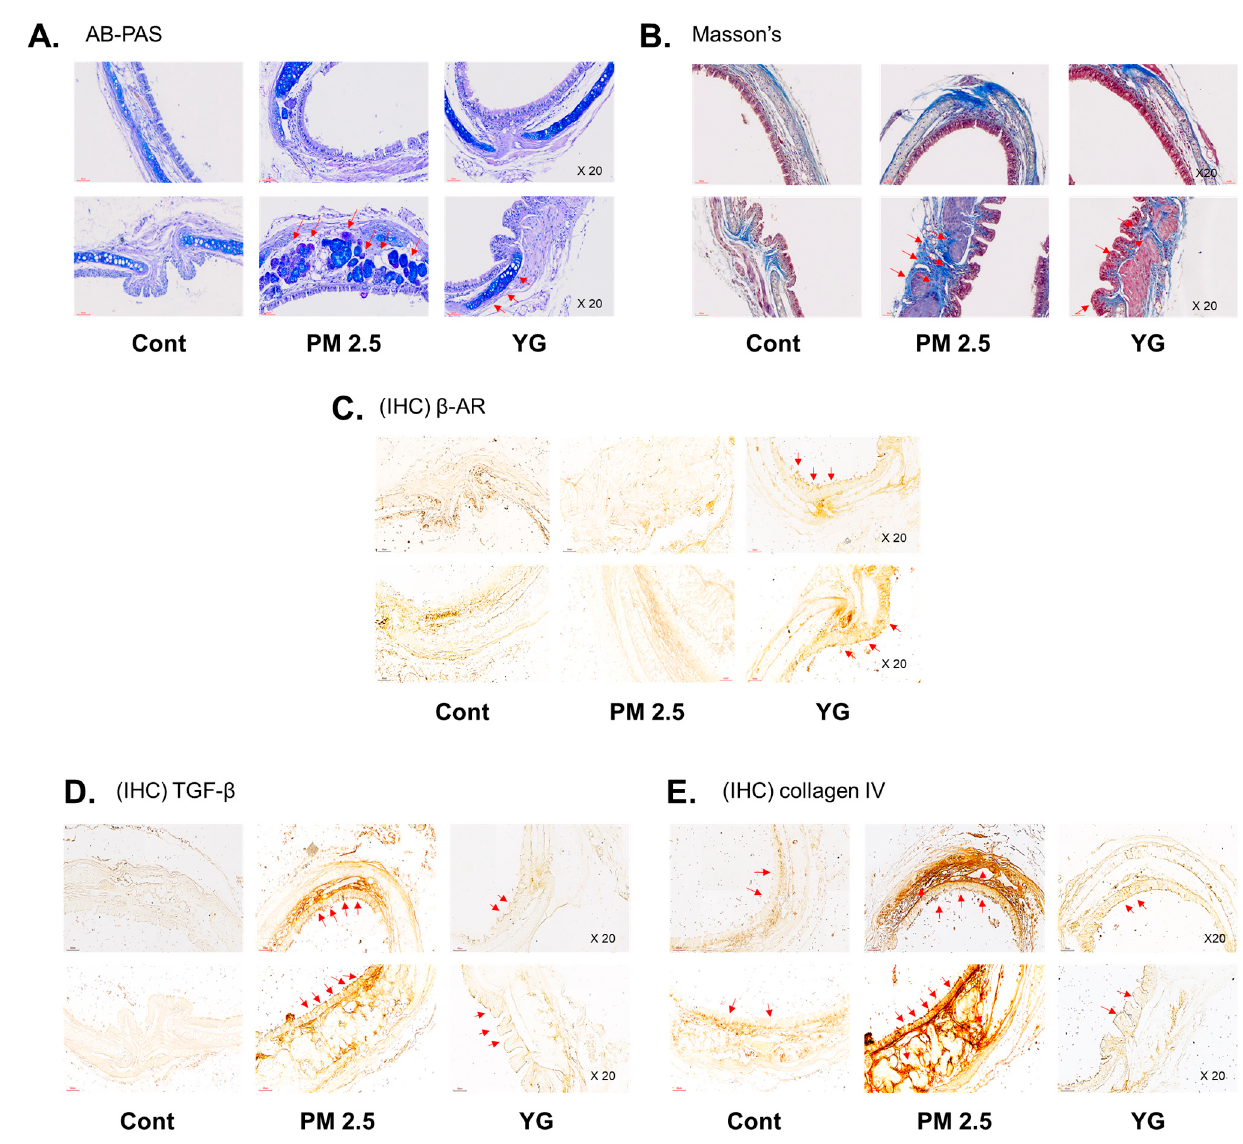
Figure 5. The effect of YG-1 extract treatment on bronchial injury in fine particulate matter (PM2.5)-stimulated mice was histologically confirmed. Representative images of AB-PAS (pseudostratified epithelium, A ) and Masson’s trichrome (collagen fibers, B ) stained tracheal in PM2.5 stimulated mice. IHC staining was performed to examine the expression of β - AR ( C ), TGF- β ( D ), and collagen IV ( E ) in bronchial tissues. Red arrows indicate the location of pseudostratified epithelium ( A ) and collagen fibers ( B ); and β -AR, TGF- β ( C ), and collagen IV ( D ) were expressed by immunohistochemistry in tracheal. Histopathological lesions and changes were assessed by histological analyses by optical microscope (magnification ×200; n = 3~4 for each group). Cont, control; PM2.5, PM2.5 exposure mice; YG-1, PM2.5 exposure mice + YG-1 treated (200 mg/kg/daily, orally); AB-PAS, alcian blue-periodic acid-Schiff staining; Massnon’s, masson’s trichrome staining; IHC, Immunohistochemistry staining; β -AR, β -adrenergic receptor antagonist; TGF- β , transforming growth factor- β .